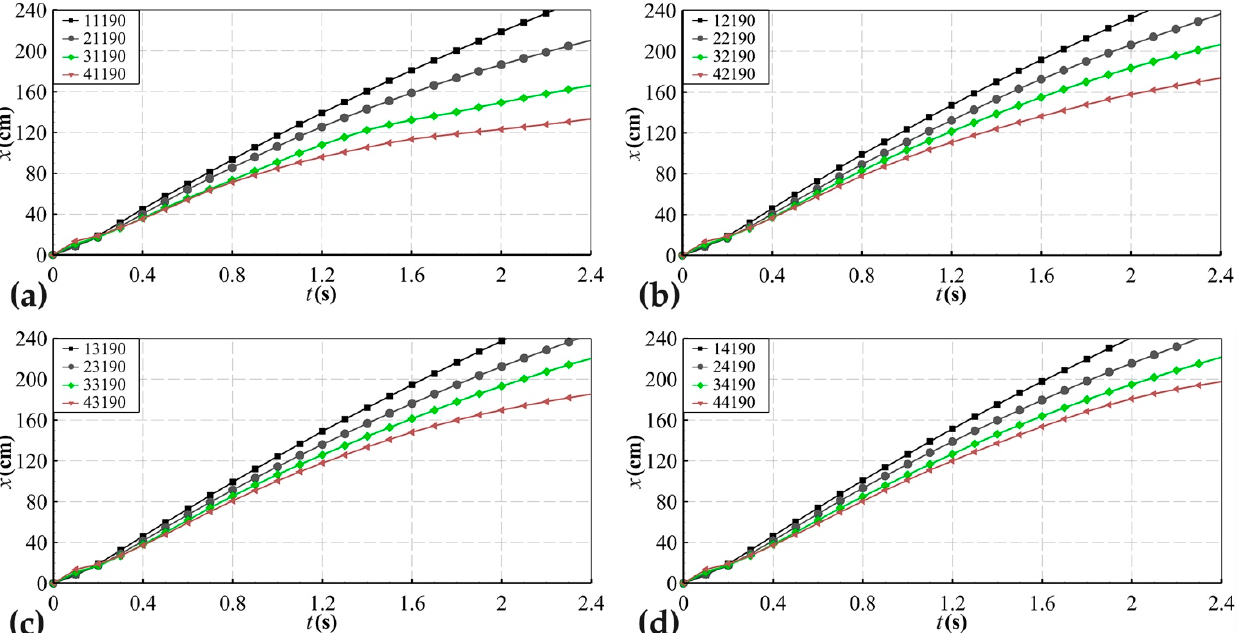
Figure 12. Comparison of the location of the center of gravity of the entire container group in the x direction after starting the drift at a 0.1 s interval. ( a ) N y = 1, N z = 1, and N x = 1, 2, 3, 4; ( b ) N y = 2, N z = 1, and N x = 1, 2, 3, 4; ( c ) N y = 3, N z = 1, and N x = 1, 2, 3, 4; and ( d ) N y = 4, N z = 1, and N x = 1, 2, 3, 4.